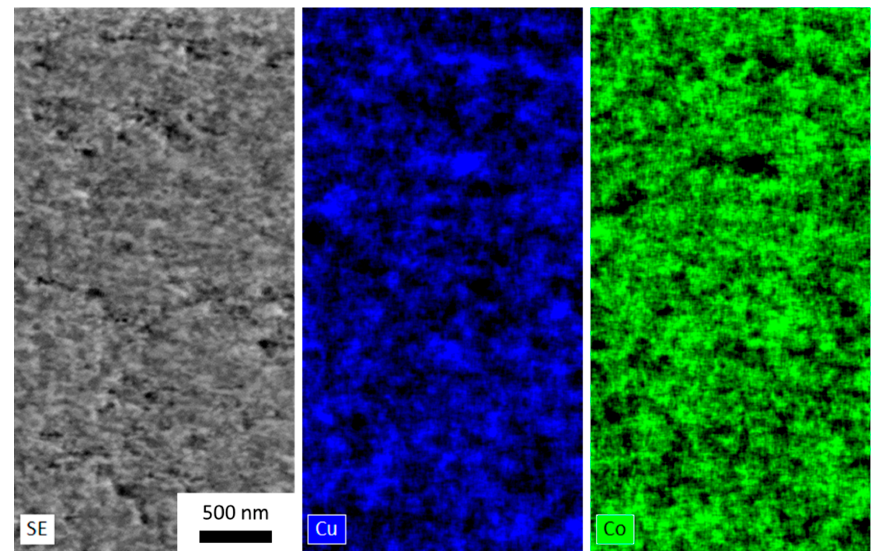
Figure 4. SEM micrograph of the large HPT sample Cu 55 Co 45, taken at r = 10 mm, with EDX maps of the same region showing the distribution of Cu ( center , blue) and Co ( right , green). Metals 2019 , 9 , x FOR PEER REVIEW